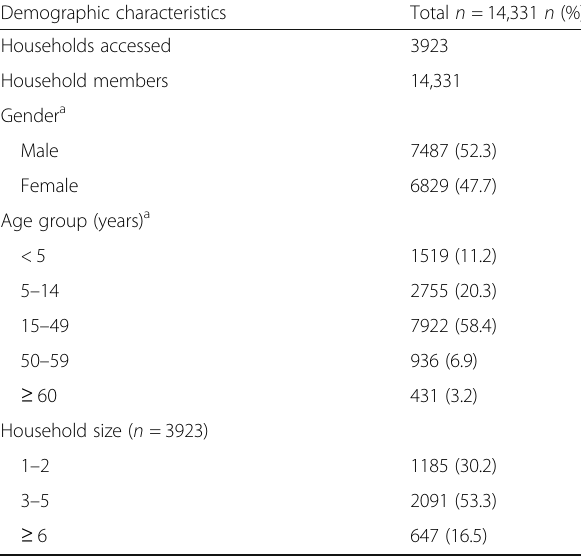
Table 1 Demographic characteristics of migrant population in RAI project areas of Myanmar, 2014 Demographic characteristics